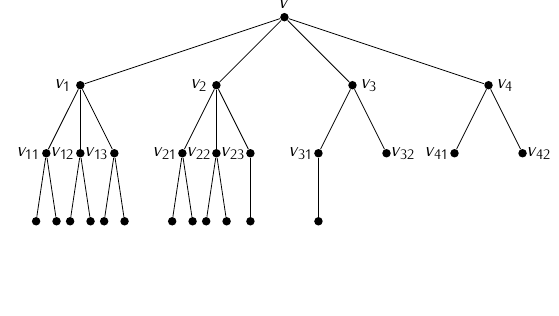
Figure 1. A greedy